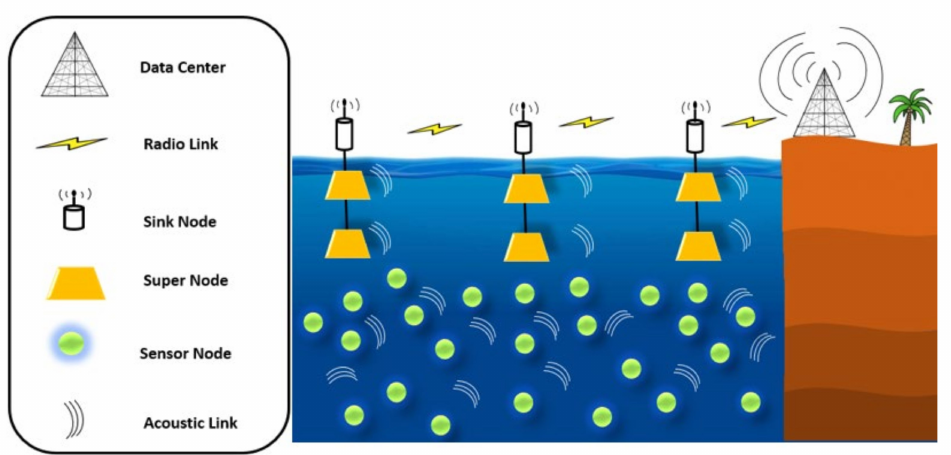
Figure 2. The proposed supernode layering based underwater network